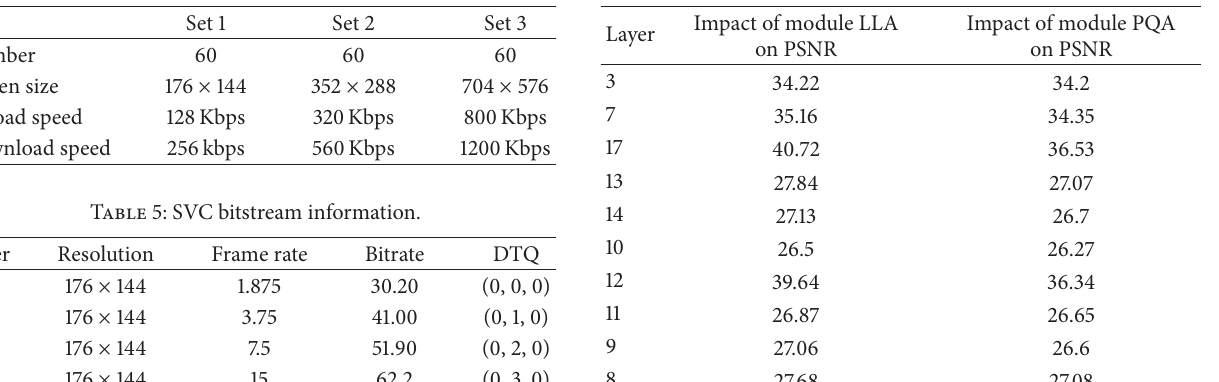
Table 4: Resource configuration for the peers.